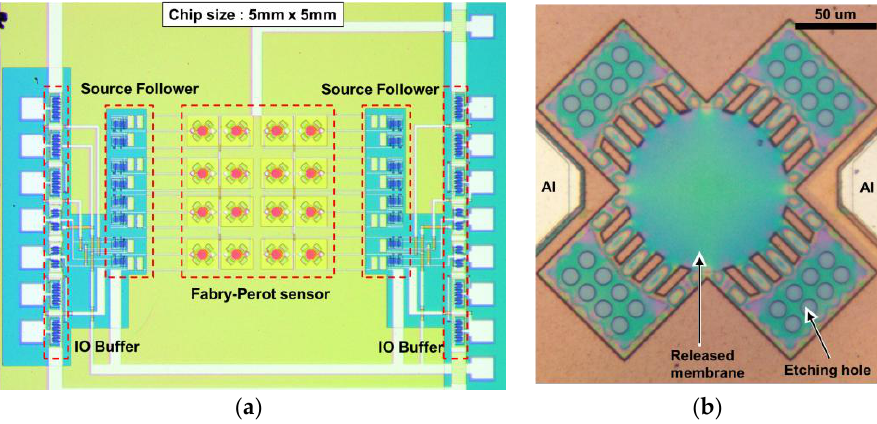
Figure 2. Photographs of the Fabry–Perot sensor interferometer. ( a ) The complementary metal oxide semiconductor (CMOS)-MEMS-based Fabry–Perot interferometer sensor with readout photocurrent circuits and ( b ) close-up view of the integrated MEMS Fabry–Perot sensor.